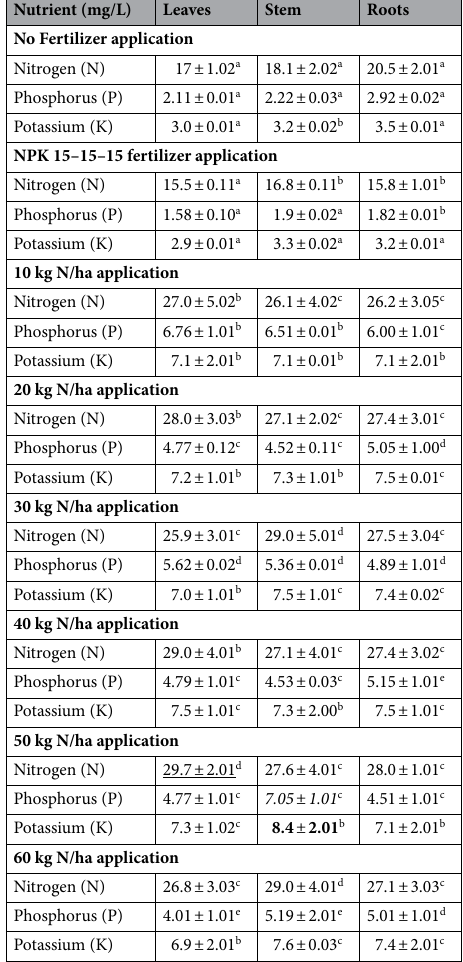
Table 7. Nutrient bioavailability and accessibility to plant organs in control, NPK 15–15–15 and Carica papaya fruit peel organic fertilized experiments using Maize ( Zea mays ) as test plant (Measured at 75 DAE). Values shown in table are means of triplicate analyses; superscripts with same letters across each plant organ for the different fertilizer treatment treatments (Organic fertilizer and control experiments) are statistically the same by Tukey’s test at 5%; Value in underline indicates highest concentration of Nitrogen in the leaf, while those in italics and bold indicates highest levels of phosphorus and potassium respectively in the